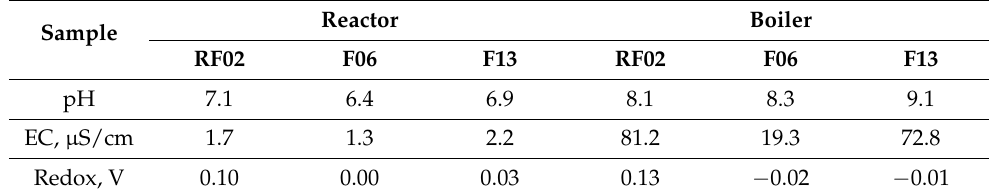
Table 2. Dynamic leaching data of leachates in the reactor and boiler after leaching for 30 days. − 0.02 − 0.01 Sample Secondary phases/microstructures at the sample surfaces were observed in all the samples during the dynamic leaching tests, as presented in Figure 7. Moreover, precipitates formed in the boiler in all tests. According to XRD analysis, precipitated Fe 2 O 3 was identified after all tests, and CaSO 4 was detected in F13, as shown in Figure 8. Furthermore, Si, Ca, Cu, Al, Fe, Zn, and S were detected in the precipitates using ICP–MS, as shown